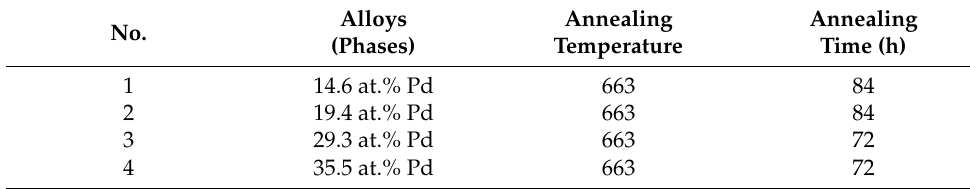
Table 2. Homogenization conditions of the prepared